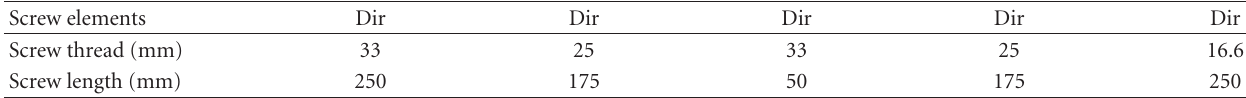
Table 3: Best set of twin screw extrusion conditions with a full conveying system (profile 2).